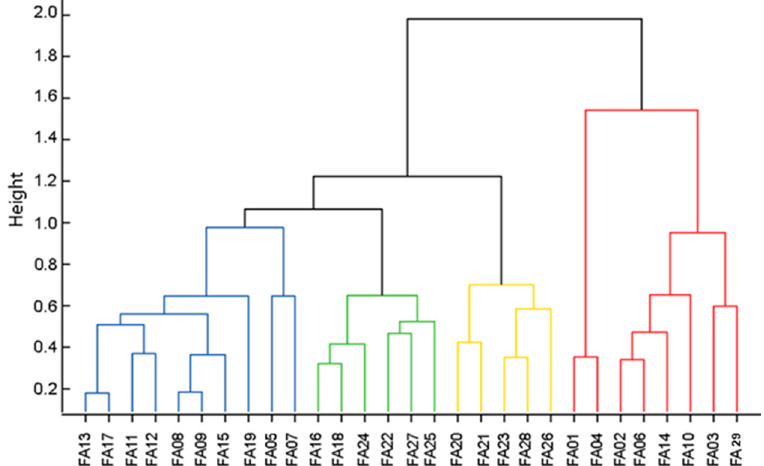
Figure 5. Cluster tree of the FA samples according to their content of Zn and Al 0 , the ANC, and the amount of FA produced in 2016. The y-axis shows the distances between the calculated values and hence is a mathematical value that expresses the dissimilarity.